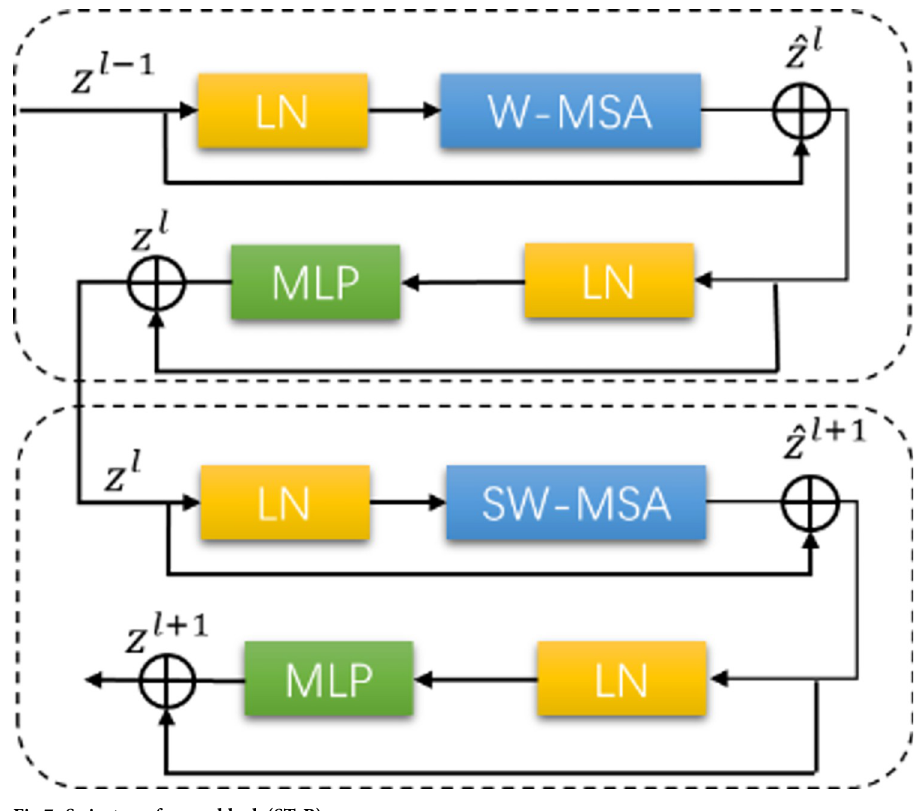
Fig 7. Swin-transformer block